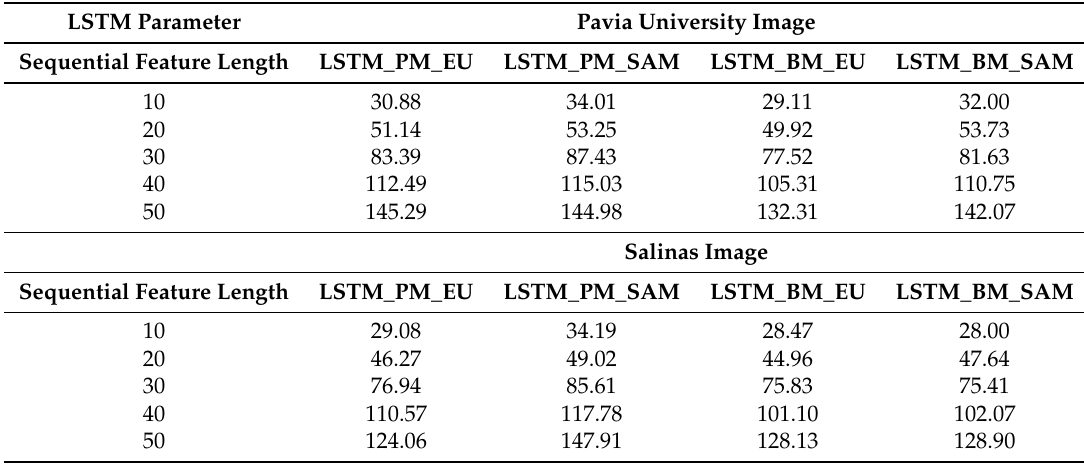
Table 5. Average training time (min) of LSTM models.